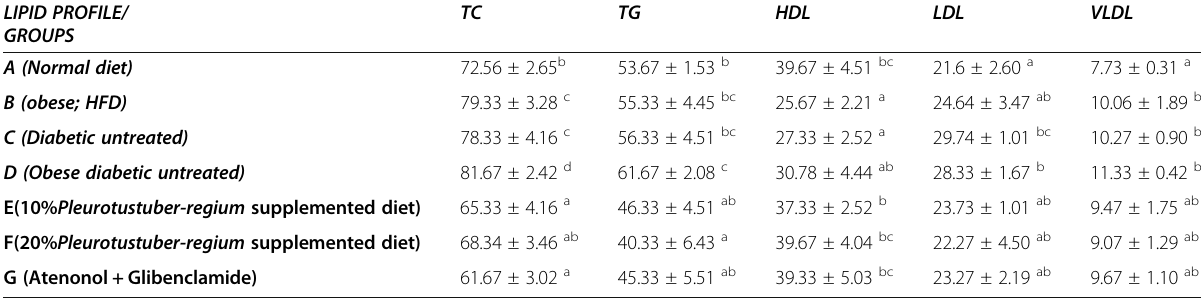
Table 9 Effect of Pleurotus tuber-regium supplemented diet on the lipid profile in the blood of the rats LIPID PROFILE/